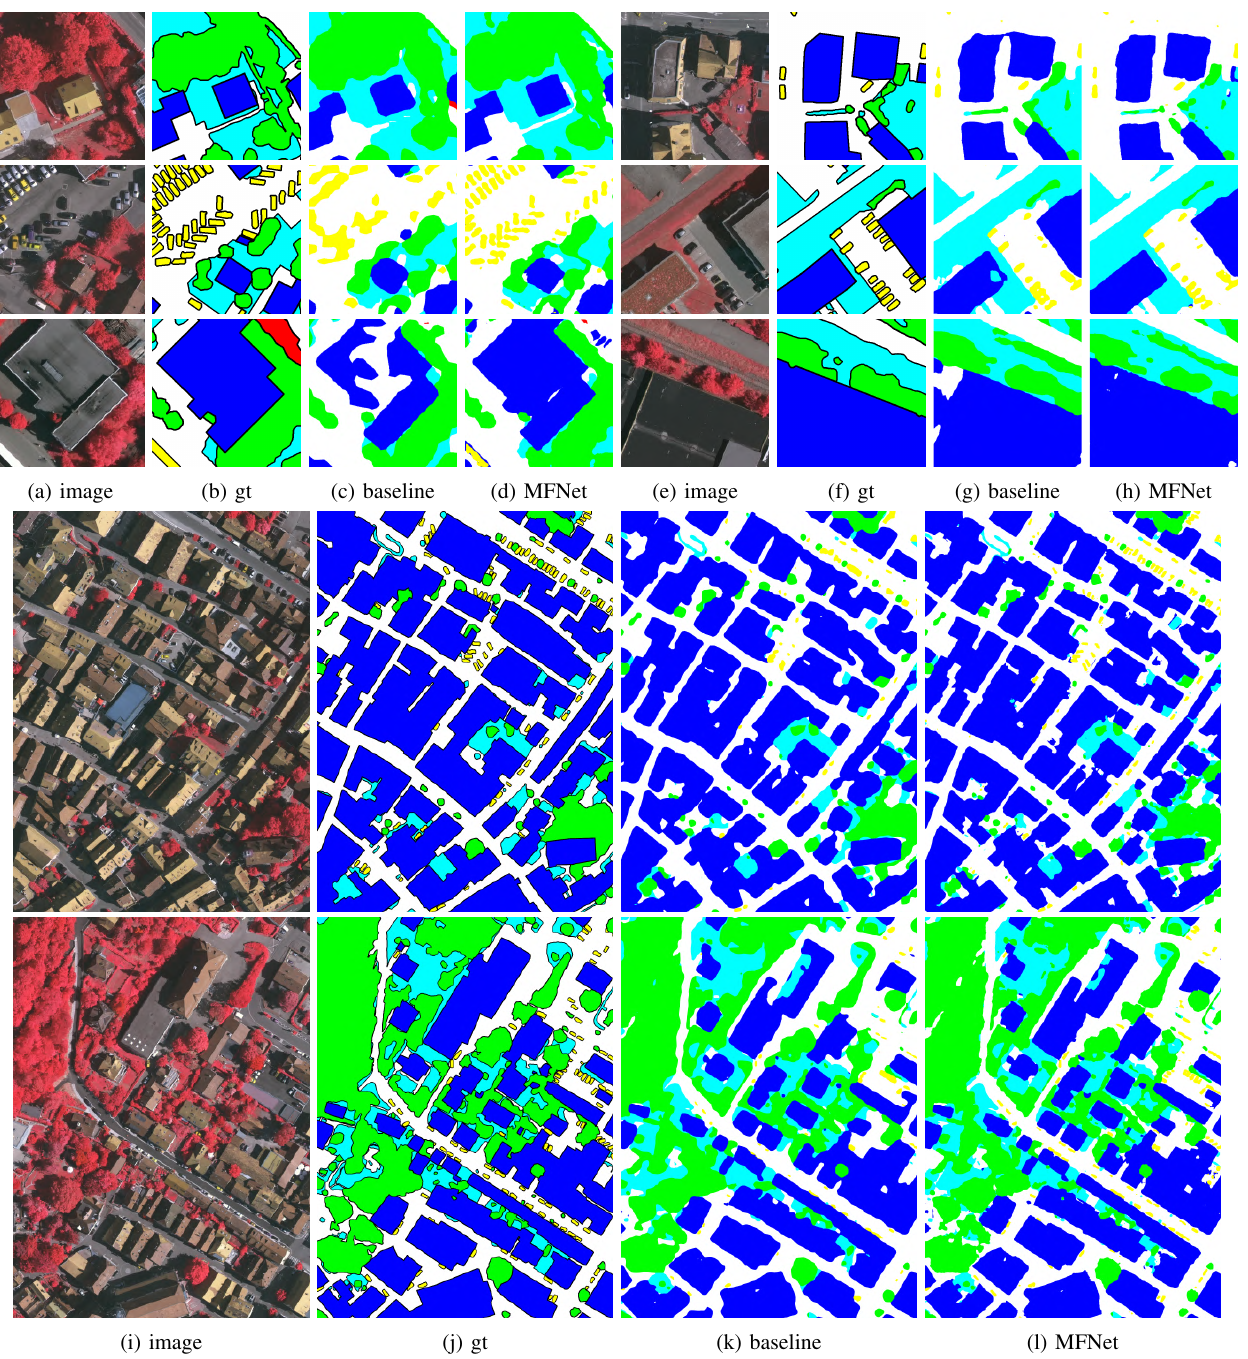
Fig. 8: visualize the results of Vaihingen dataset. Figure 8. Visualization of the results of the Vaihingen dataset. Notably, the baseline is